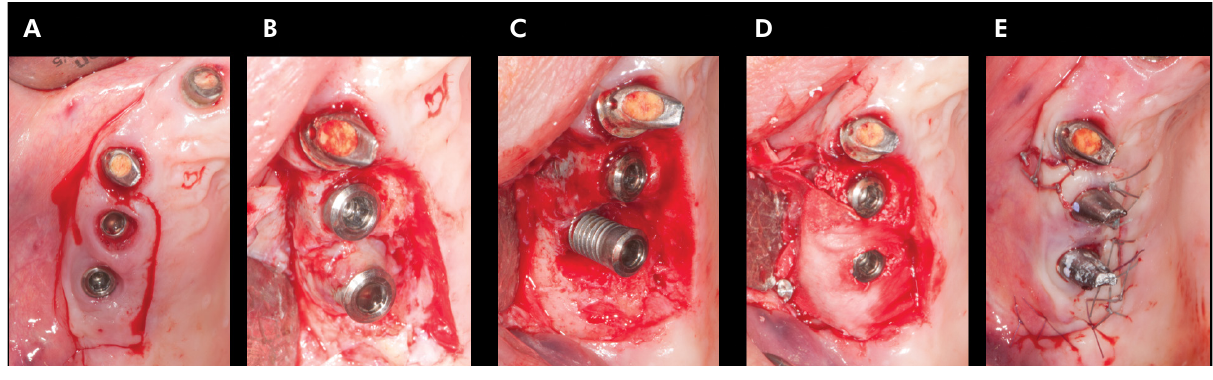
Figure 2. Surgical phases: flap design, intraoperative view of the lesion (b), degranulation of the defect (c), autogenous bone graft + allograft apposition covered by the membrane fixed buccally and palatally using titanium pins (d), primary intention flap suturing (e).